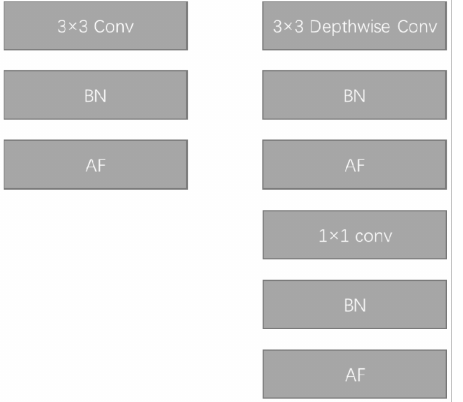
Figure 6. A 3 × 3 convolution and corresponding depthwise separable